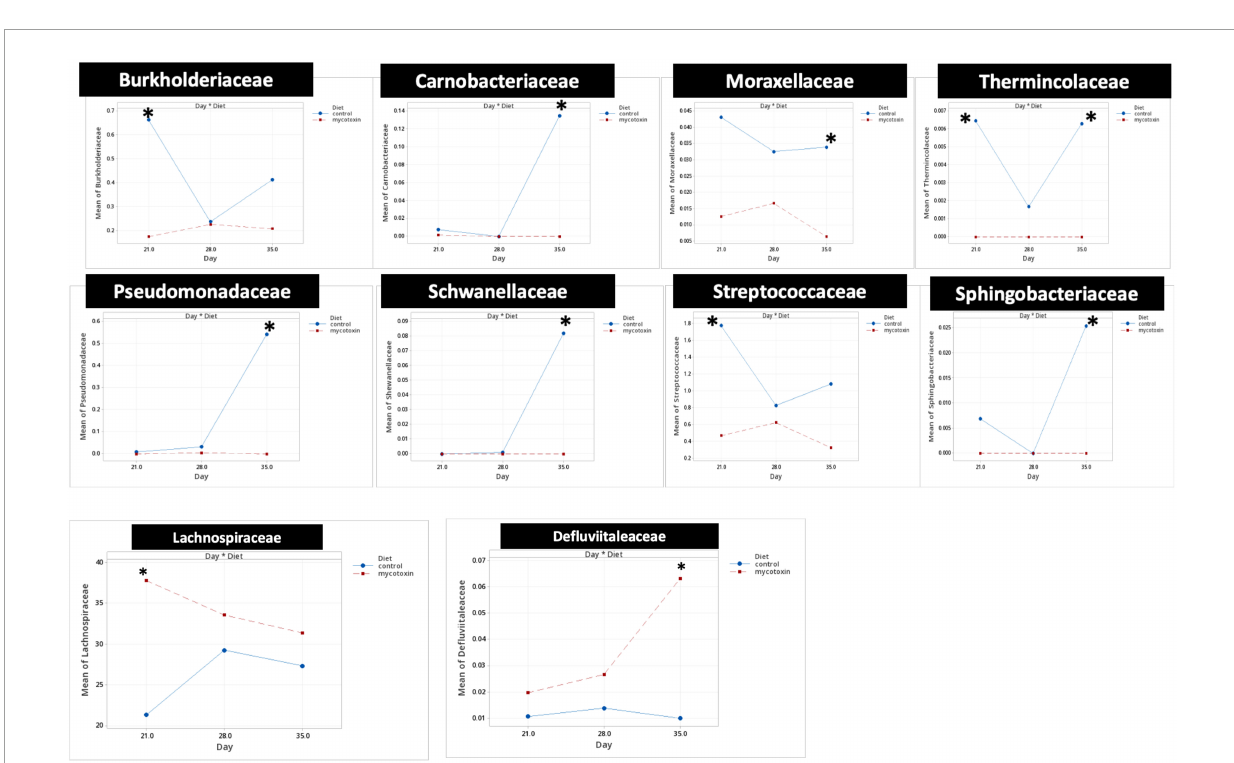
FIGURE5 Bacterial families found to be significantly different ( P < 0.05) between treatments during the study. Broilers were fed control or mycotoxin (FUM 3 mg/kg diet + DON 4 mg/kg diet). All birds received 1 × 10 8 CFU/bird of C. perfringens on d 19 and 20. Cecal digesta was analyzed for microbiome composition at family level using 16S rRNA sequencing at 1, 7, and 14 days post-infection. Values are presented as least squares means n = 8 (Kruskal-Wallis tests corrected by FDR). Asterisks denote significant difference. * P <